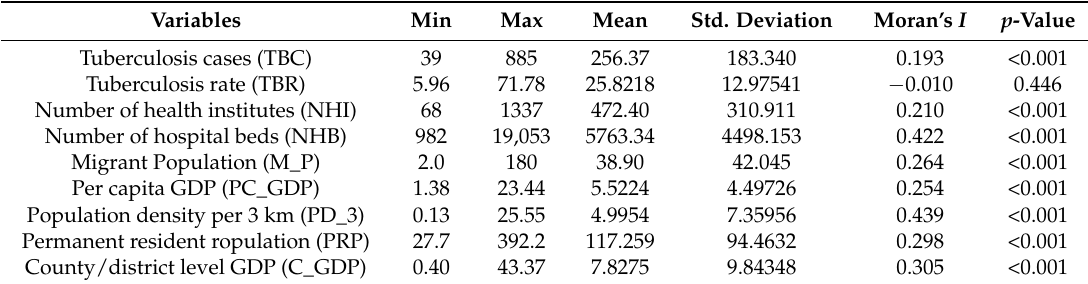
Figure 2. Description of outcome and predictor variables during the study period. Table 1. Description of outcome and predictor variables.